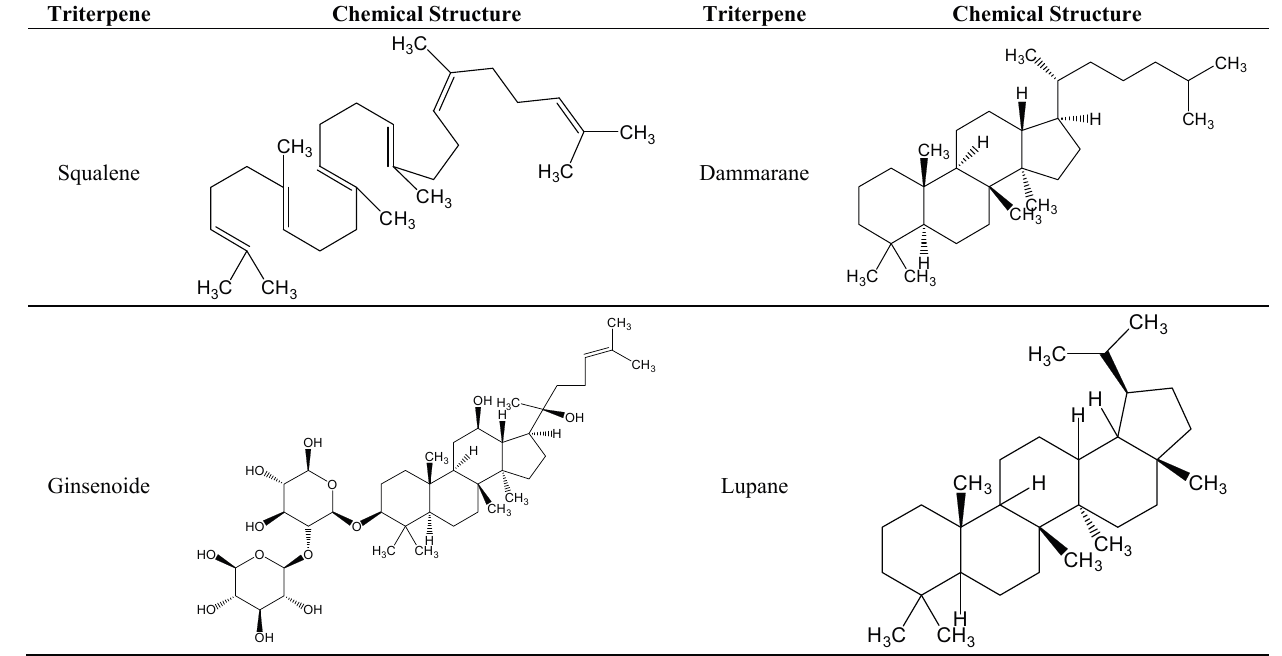
Table 2. Examples of triterpenes presenting cytotoxic